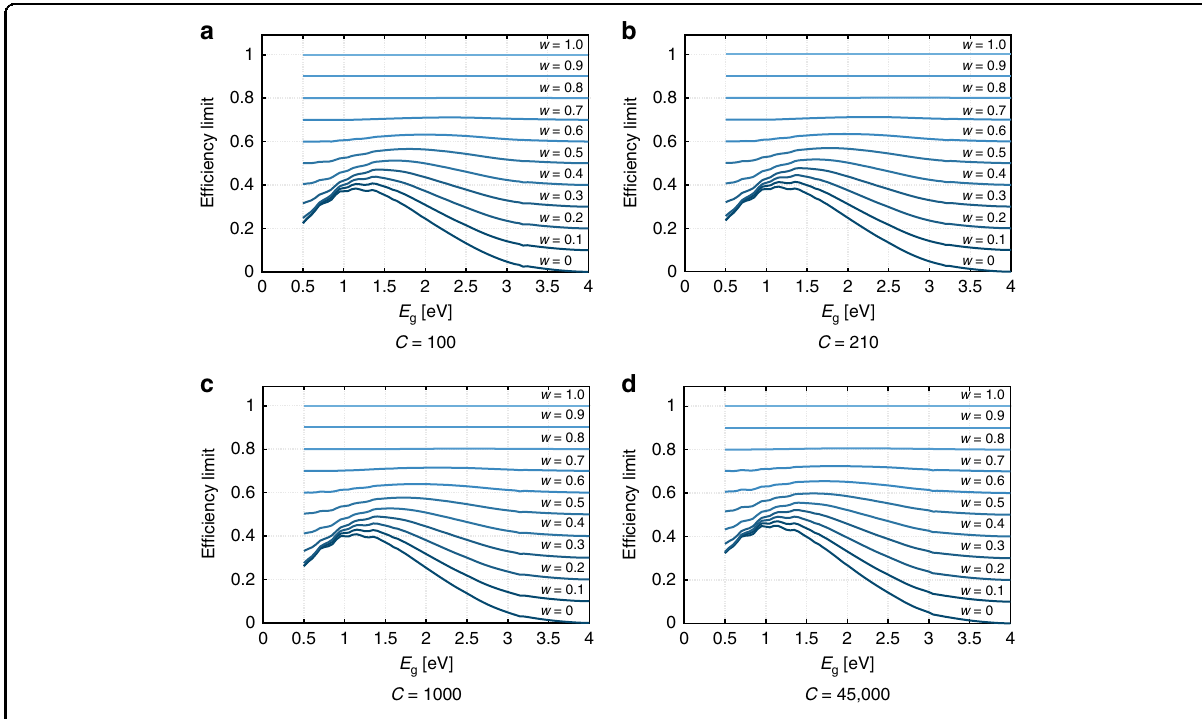
Fig. 3 Limit of the total effective ef fi ciency for different w and C = 100, 210, 1000,